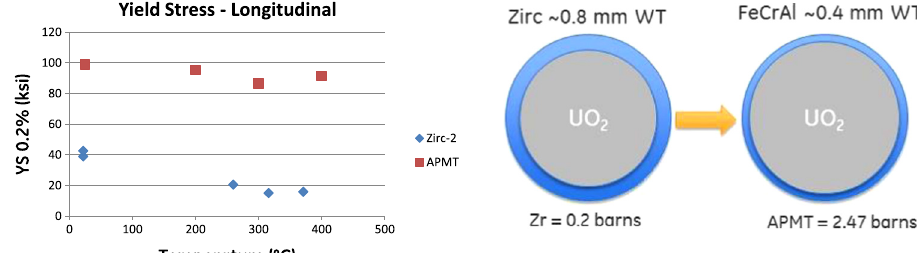
Fig. 8. Mechanical and neutron absorption properties of APMT and Zircaloy-2.